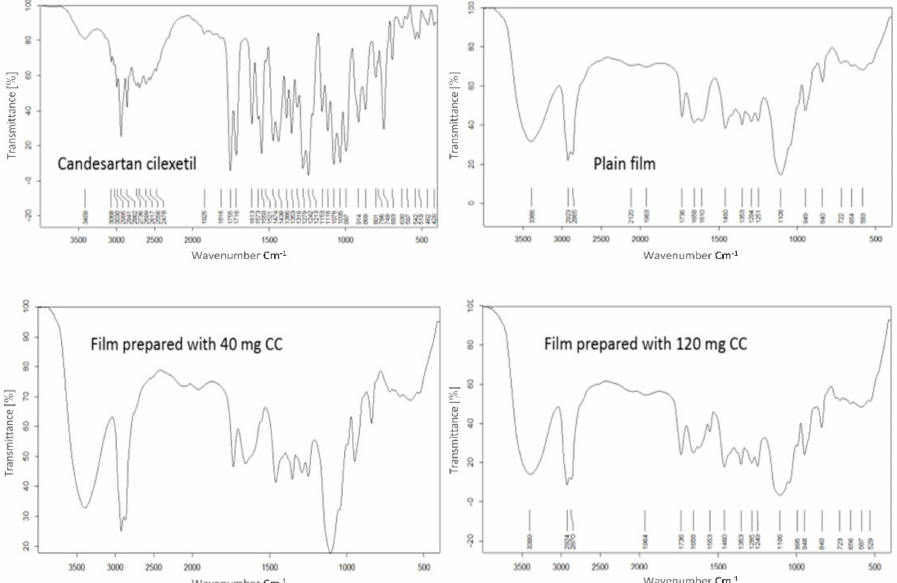
Figure 3. FTIR of CC, plain film, and different selected prepared films for